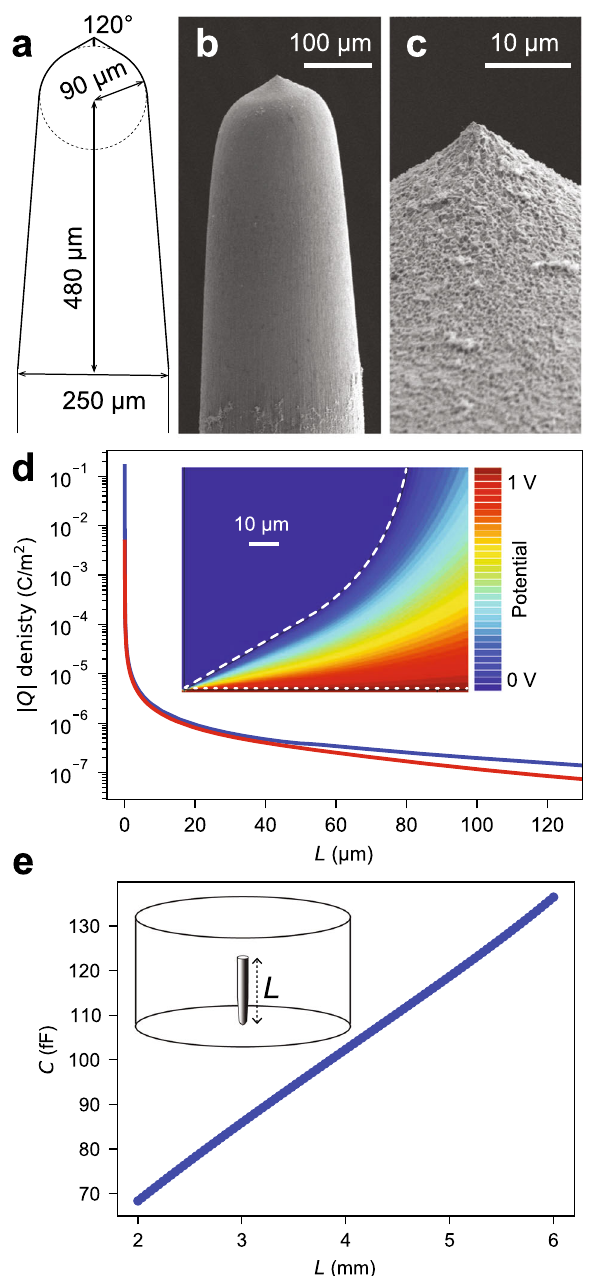
Fig. 1 Capacitance of the scanning tunneling microscope (STM) junction. a Model of the tip based on the scanning electron microscope (SEM) images ( b , c ). b , c SEM images of the tip. d Simulated surface charge density in the junction biased by the voltage of 1 V. Distribution of the potential in the junction (inset). The dashed white lines represent the outline of the tip and the sample. e Dependence of the junction capacitance C on the length L of the tip wire. Model of the STM head used for simulating C